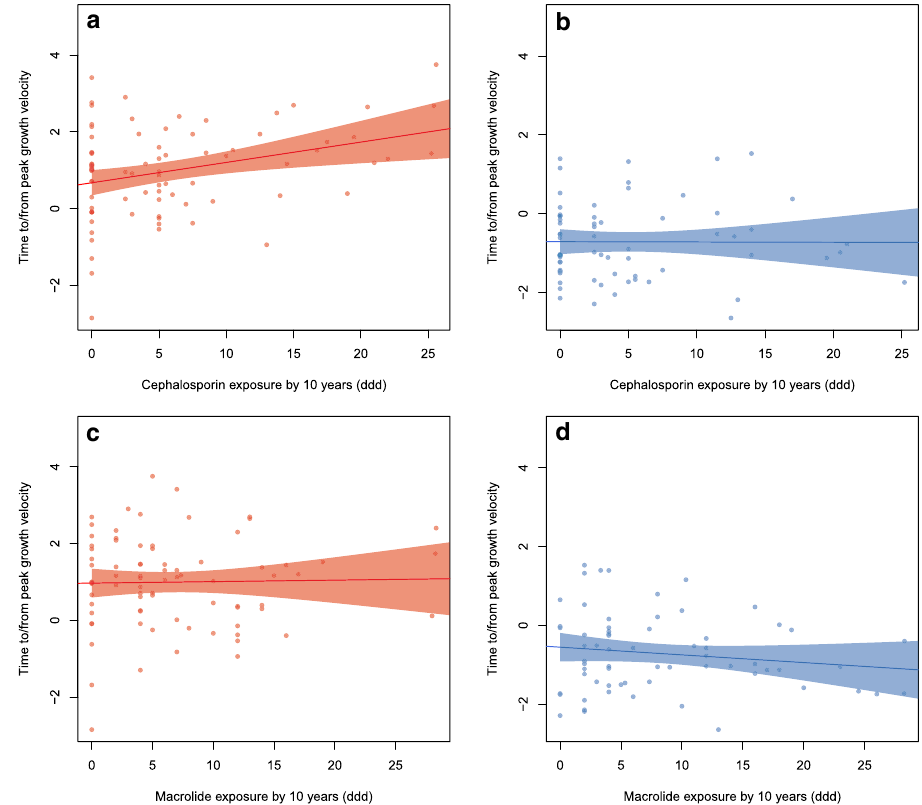
Figure 4. ( a ) Association between exposure to cephalosporin and pubertal timing (time to/from peak growth velocity) in girls. ( b ) Association between exposure to cephalosporin and pubertal timing (time to/from peak growth velocity) in boys. ( c ) Association between exposure to macrolide, and pubertal timing (time to/from peak growth velocity) in girls. ( d ) Association between exposure to macrolide, and pubertal timing (time to/ from peak growth velocity) in